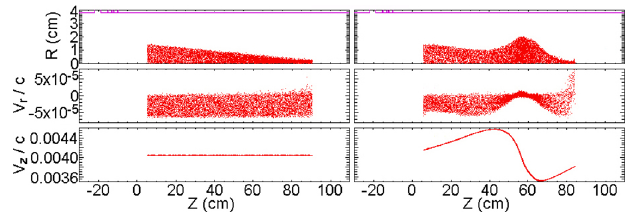
FIG. 24. (Color) Beam phase space comparison between trans- verse focusing without (left) and with (right) an axial velocity tilt at t (cid:4) 1000 ns , shown as particle plots in f r; z g (top), f z; v g (bottom) coordinates. The radial defocusing (middle), and f z; v z effect imparts excess divergence to the longitudinally compress- ing portion of the beam in a time-dependent manner.